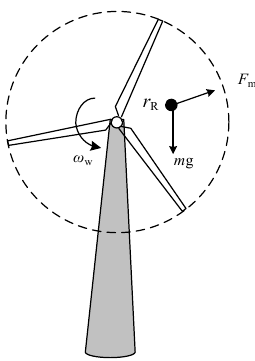
Figure 2. Force analysis of the imbalanced mass block.